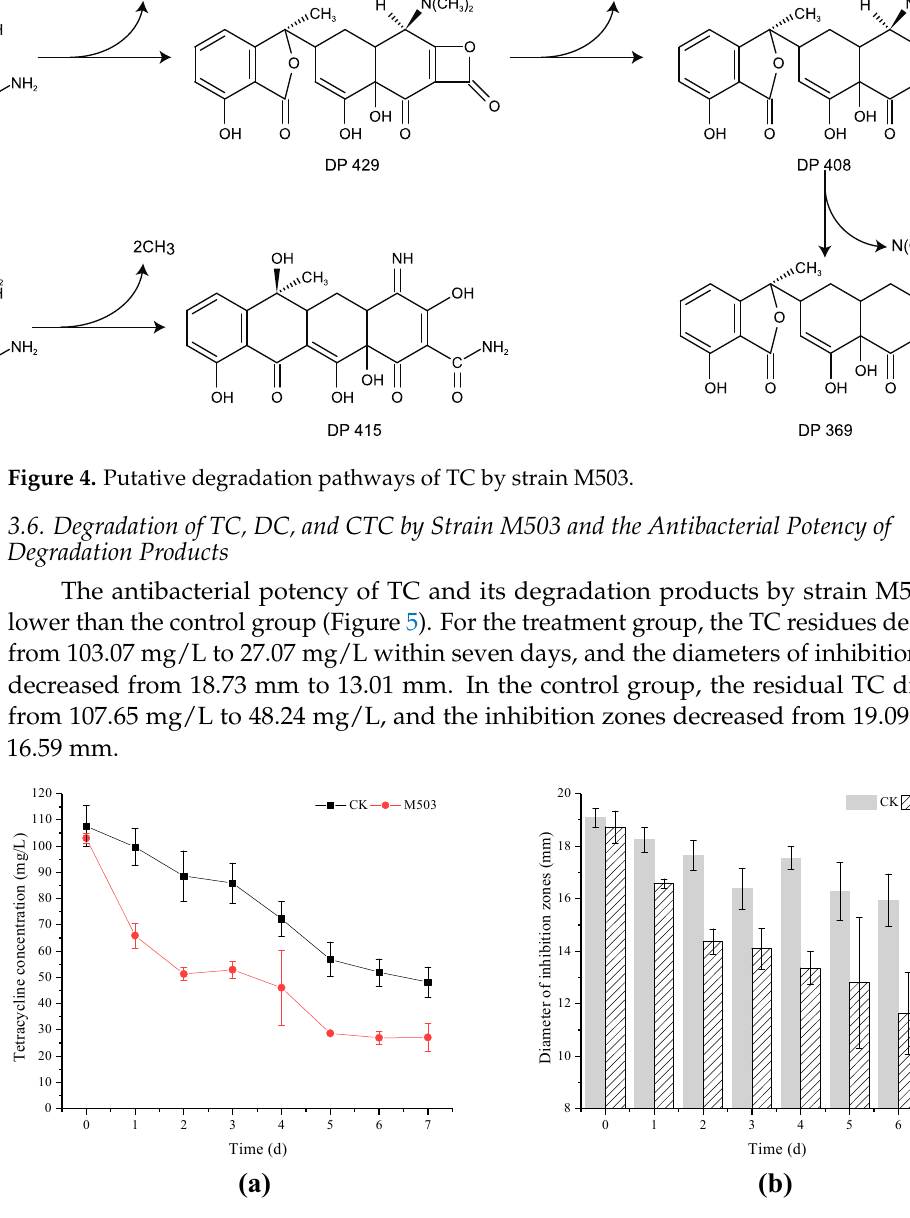
Figure 5. Tetracycline degradation curves (red, M503: group with strain M503; black, CK: group without strain M503) ( a ). Antibacterial potency of the degradation products of two groups ( b ). Values are expressed as mean of three replicates with standard deviations.